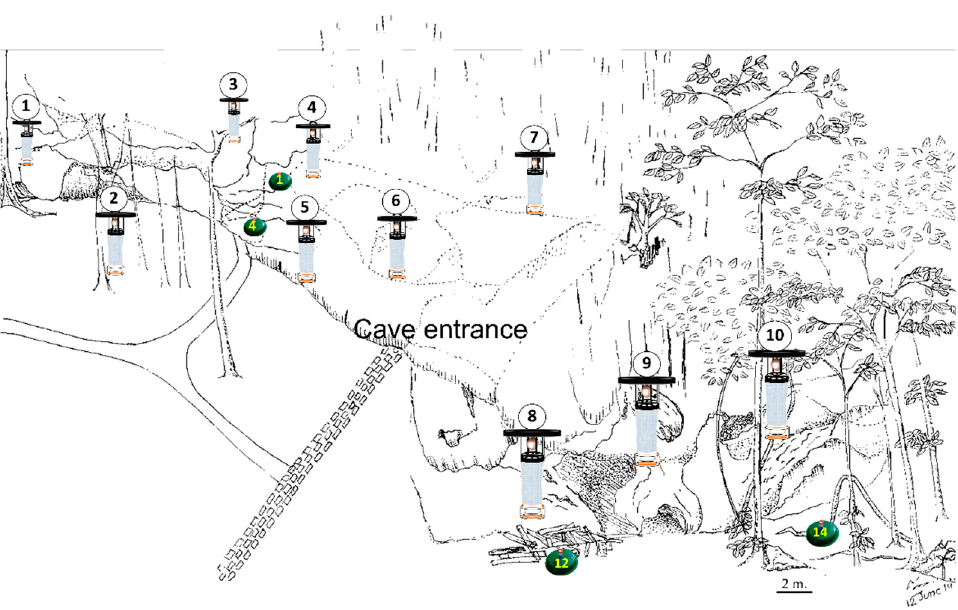
Figure 1. Trap positions in the study site. Ten CDC light traps (white) were positioned around the area of Tham Rakhang Thong Cave, Satun Province, Thailand. Additionally, emergence traps were also located inside (ten traps) and outside (eight traps) the cave. Four emergence traps with positive findings are shown in green.